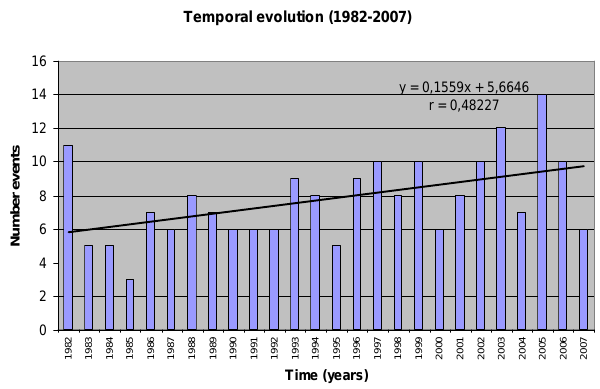
Figure 8. Monthly distribution of casualties produced by floods in Catalonia Fig. 8. Monthly distribution of casualties produced by floods in (1982-2007) Catalonia